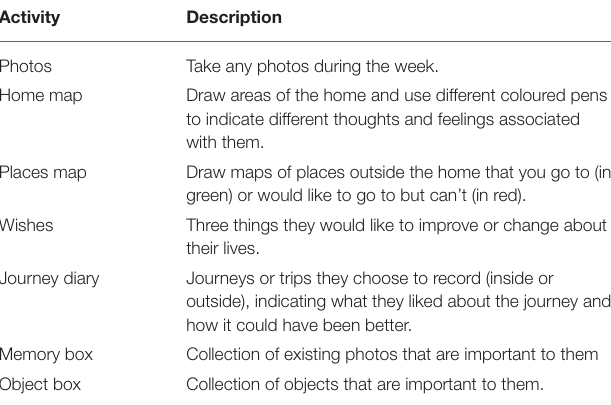
TABLE 1 | Summary of “home and life scrapbook”